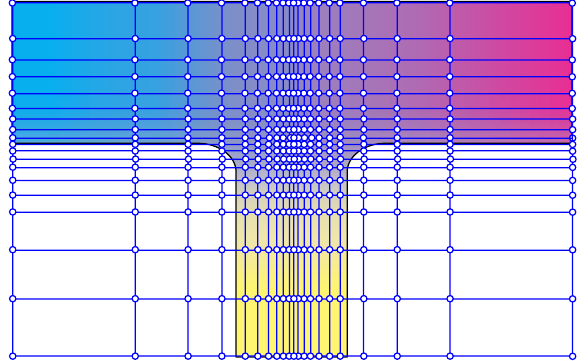
Figure 4: Material definition mesh